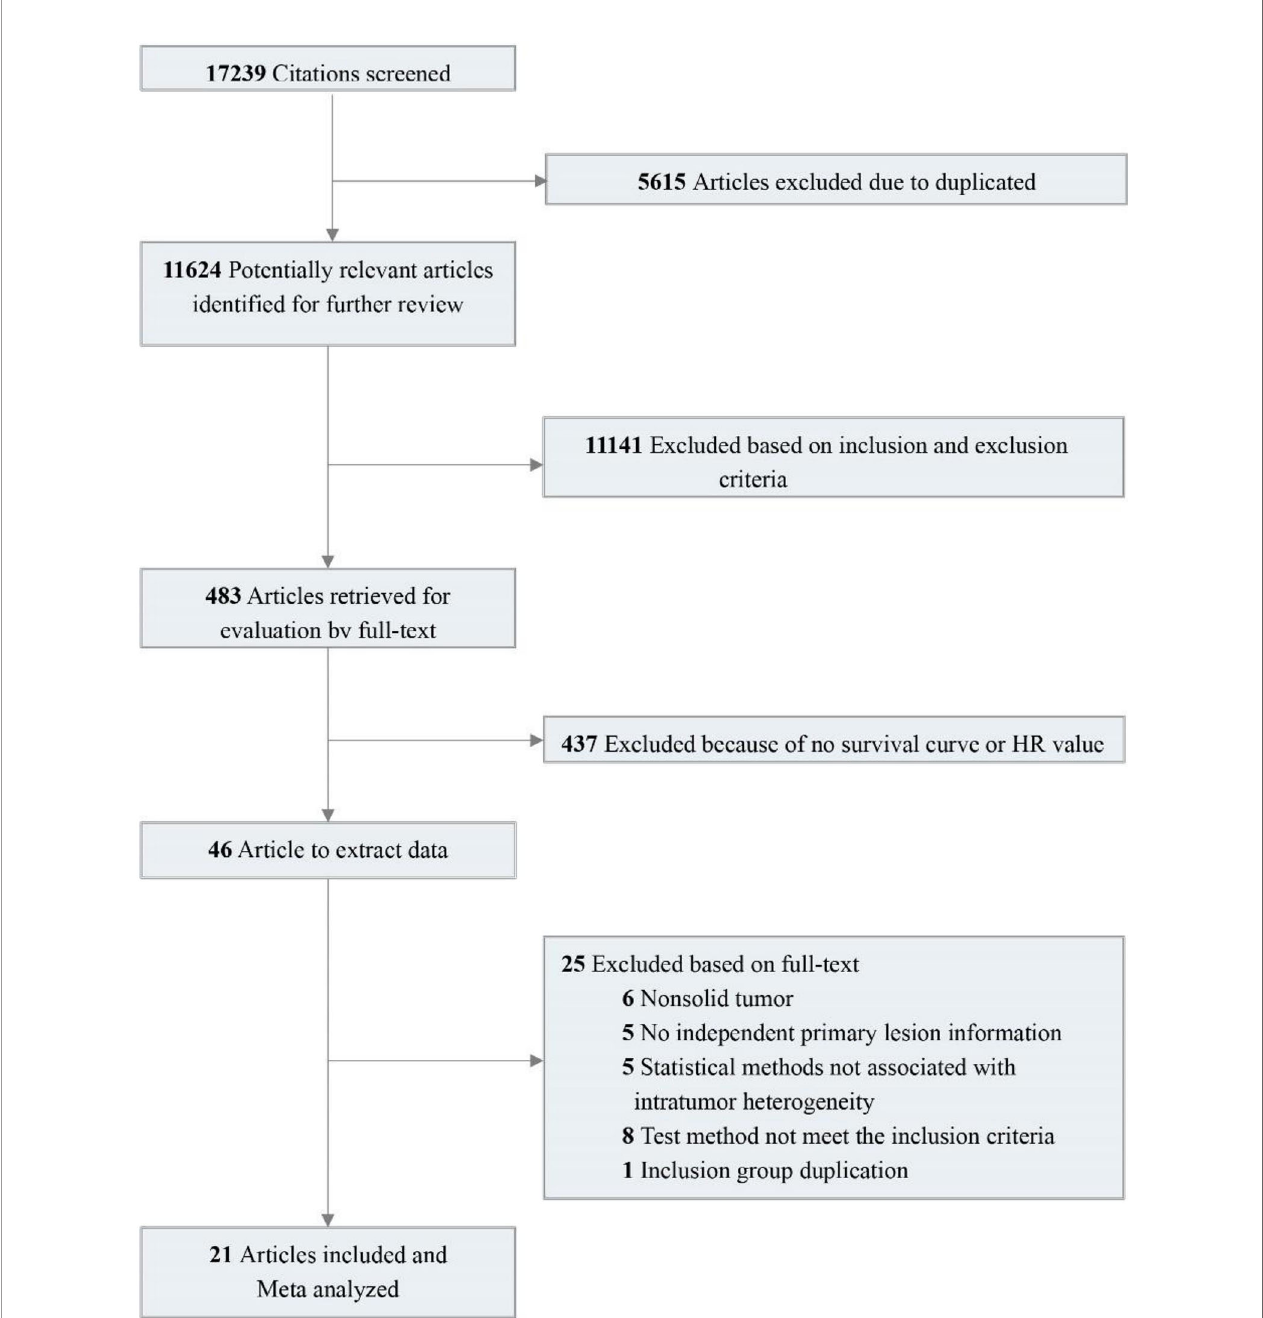
FIGURE 1 | A fl owchart of paper selection in our